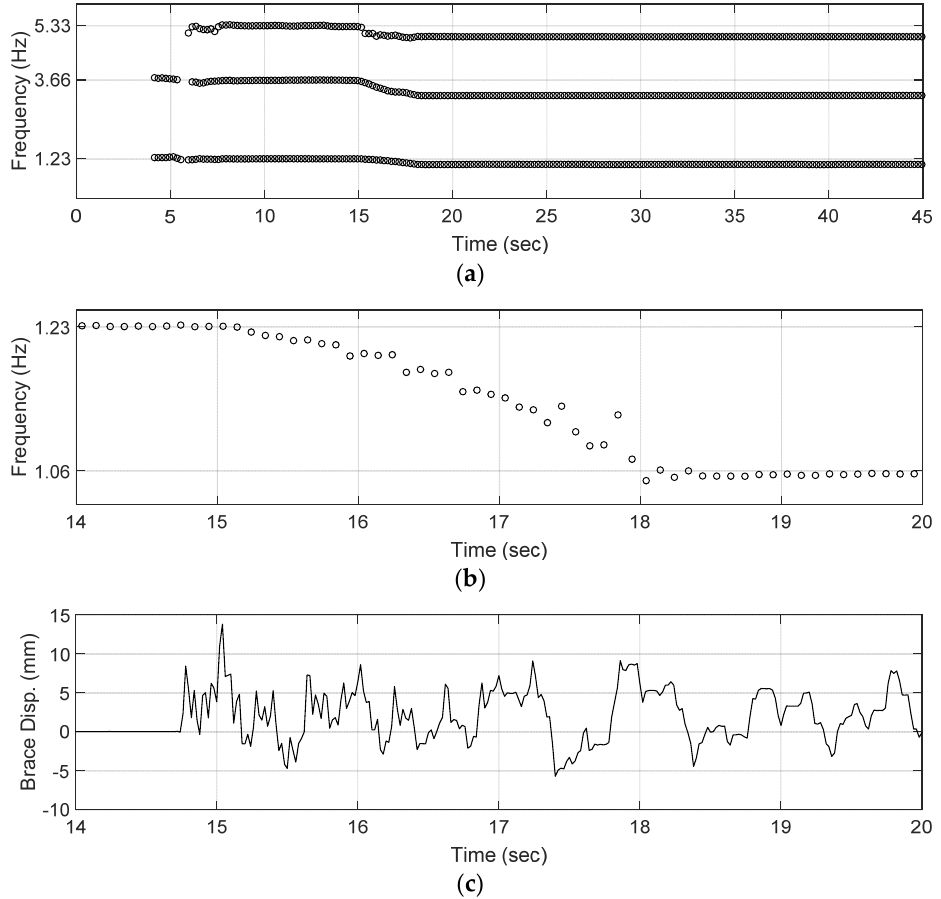
Figure 9. The identification result of the 3-story frame during the shaking table test. ( a ) Identified frequency over time (the gray grids indicate the results identified from the white-noise excitaiton); ( b ) identified frequency (first mode close-up); ( c ) relative displacement of brace (Lock-up system).